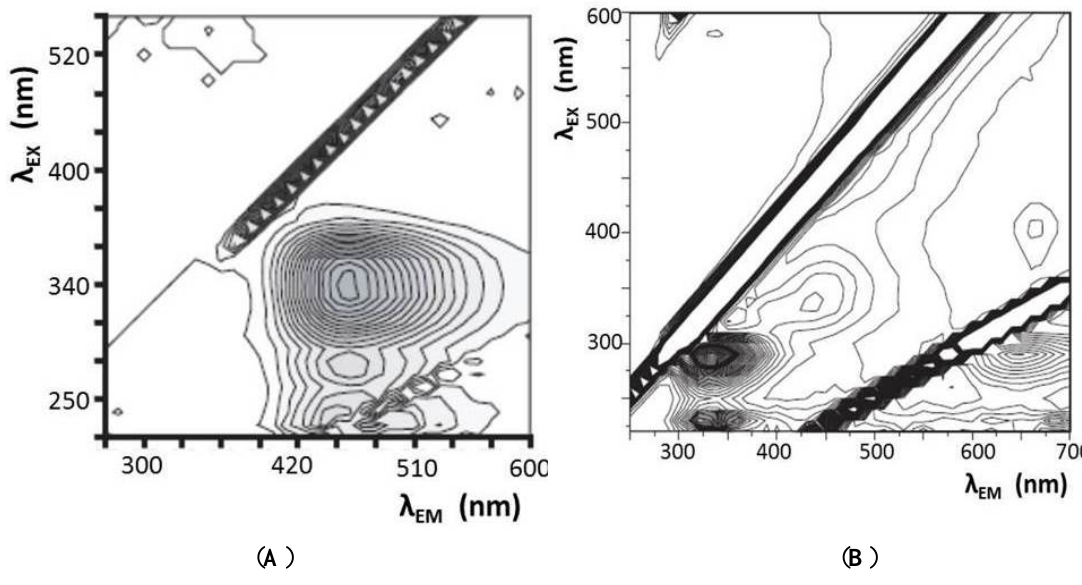
Figure 15. 2-D fluorescence spectrum ( A ) nicotineamide dinucleotide (NADH) (pH = 7) and ( B ) Sacharomyces cerevisiae SP4 immobilized in